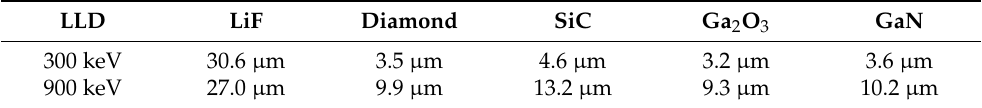
Table 5. Optimal semiconductor thickness with optimal LiF converter layer thickness for diamond, SiC, Ga 2 O 3 and GaN semiconductor materials. The optimal converter layer thicknesses are 30.6 µ m for 300 keV LLD and 27.0 µ m for 900 keV LLD, as shown in Table 1.